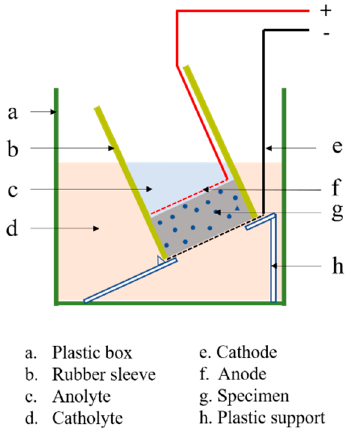
Figure 1. Arrangement of the migration set-up.